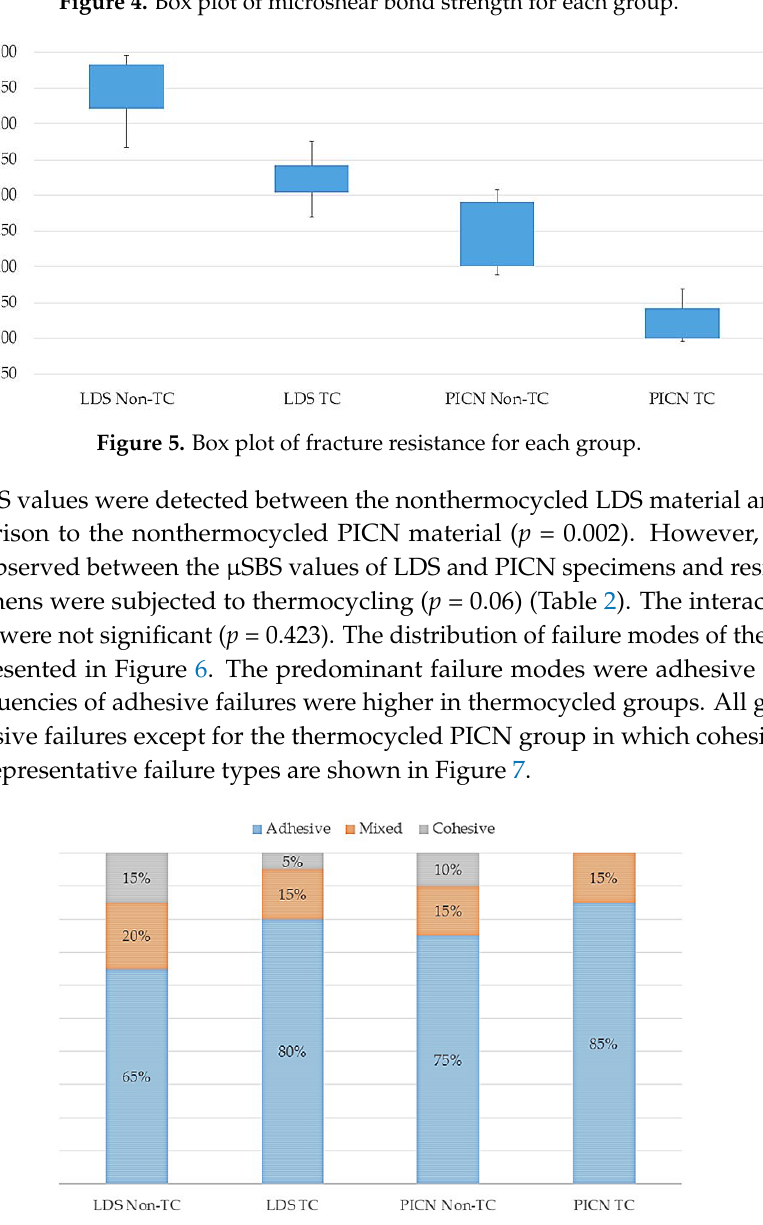
Figure 7. Stereomicroscope representative images showing ( a ) adhesive; ( b ) mixed; ( c ) cohesive failures of specimens subjected to microshear bond-strength test (40× magnification). The fracture-resistance values of LDS hybrid abutments were significantly higher than PICN abutments regardless of storage condition ( p < 0.001). When thermocycled and nonthermocycled specimens were compared within each material group, thermocycling was found to significantly decrease the fracture resistance of the abutments ( p < 0.001). For the fracture-resistance test, there was no interaction between storage condition and the materials ( p = 0.6918). Failures were detected on the ceramic material, and abutment screw failures were not detected. Fractures were observed to be located in the interproximal area where compressive and tensile stresses met and where ceramic copings were thinnest. Macroscopic images revealed (Figure 8) the detachment of ceramic copings from the titanium insert bases in thermocycled abutments. Figure 8. Macroscopic image showing failures of LDS and PICN hybrid abutments after fracture-resistance test. Failure within ceramic material was detected at nonthermocycled LDS and PICN abutments and ceramic detachment was observed at thermocycled hybrid abutments (LDS TC and PICN TC).